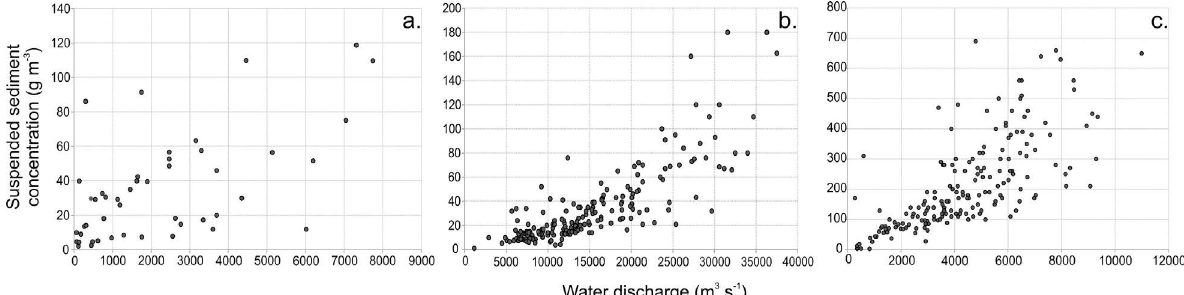
Fig. 3 Scatter plots of suspended sediment concentration versus water discharge for the Anabar River at Saskylakh (a), the Lena River at Tabaga (b), and the Indigirka River at Vorontsovo (c).